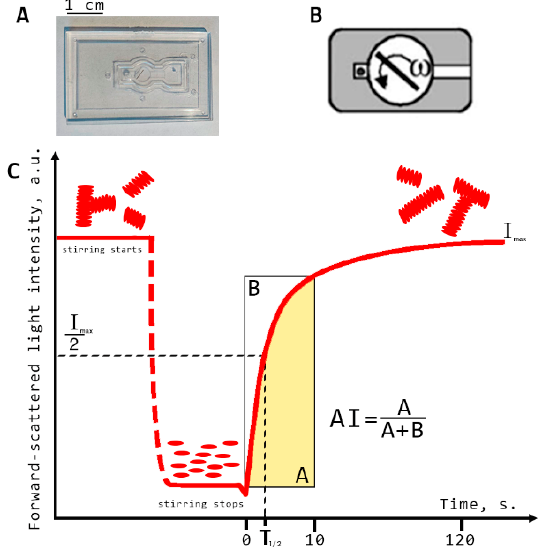
Figure 3. Schematic representation of diffuse light scattering for assessing the parameters of RBC aggregation: aggregation index (AI) and characteristic aggregation time (T 1/2 ). ( A ) photo of the experimental microchip; ( B ) schematic layout of the microchip; ( C ) RBC spontaneous aggregation kinetics curve measured with RheoScan AnD-300 with schematic indication of the aggregation indices: Imax, forward scattered light intensity at maximum RBC aggregation; AI, ratio of the RBCs participating in aggregation during the first 10 s of measurement in relation to the total number of cells; T 1/2 , characteristic aggregation time, defined as the time required to reach half the value of the maximum light intensity for measurements with a duration of 120 s. aggregation kinetics (A) to the total area (A + B) over for the first 10 s time interval. AI indicates the normalized quantity of aggregated RBCs during the first 10 s of the exper- iment. Average characteristic time of aggregate formation (T 1/2 , s) is defined as the time required to reach the half-maximum value of light intensity for measurements with a duration of 120 s. This parameter indicates the characteristic time required to reach the 50% level of aggregation.